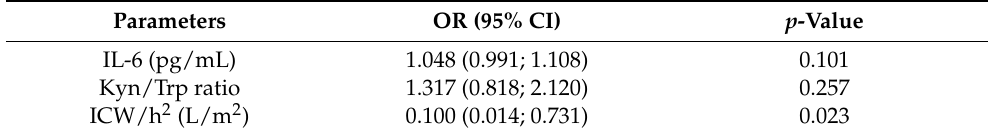
Table 2. Association of fatigue with IL-6, Kyn/Trp ratio (IDO activity), and ICW/h 2 (index of muscularity).